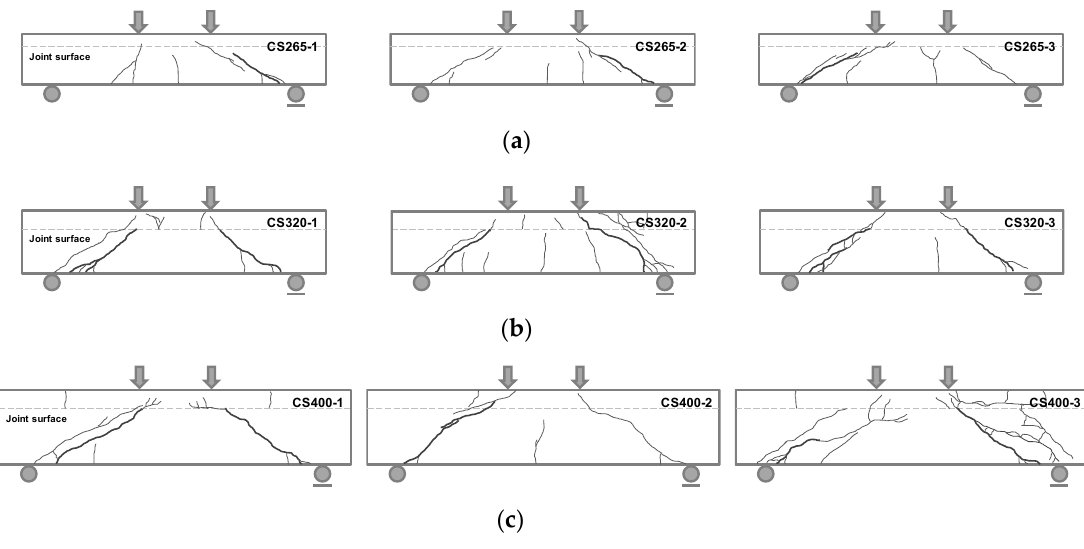
Figure 10. Crack patterns of CS series at peak load: ( a ) CS265; ( b ) CS320; ( c ) CS400.